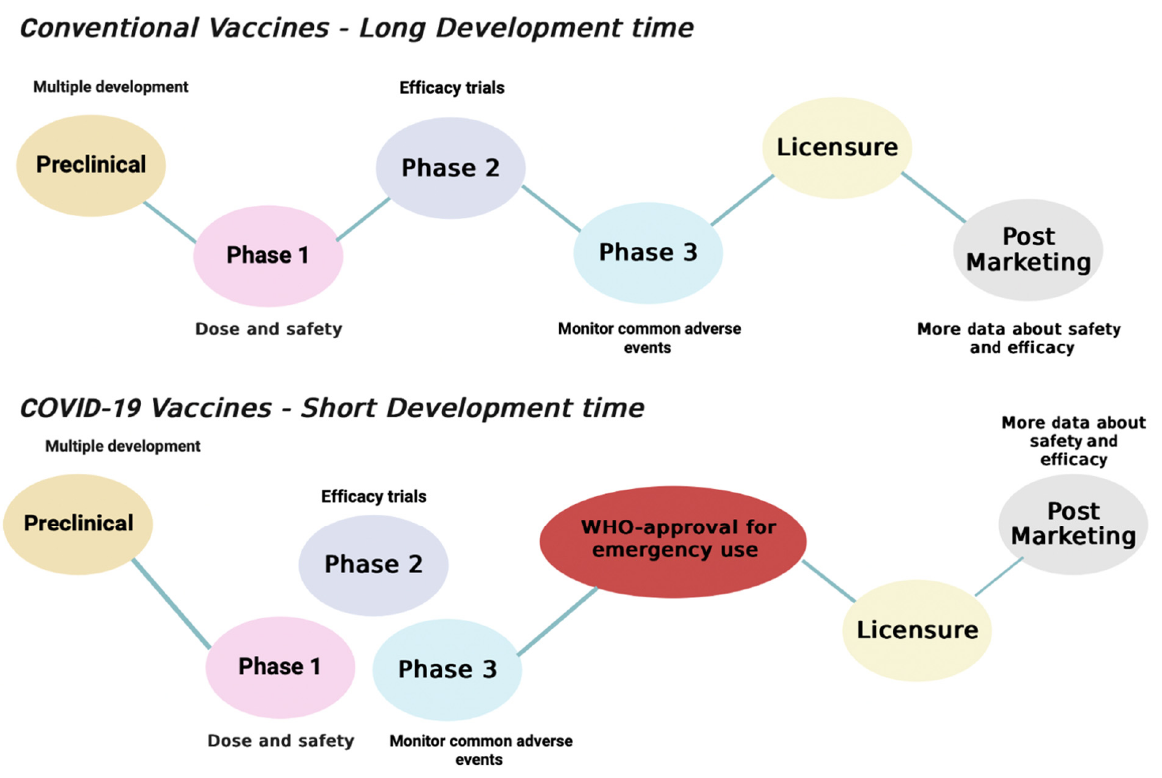
Figure 1. Development of COVID-19 vaccine in comparison to other vaccines.